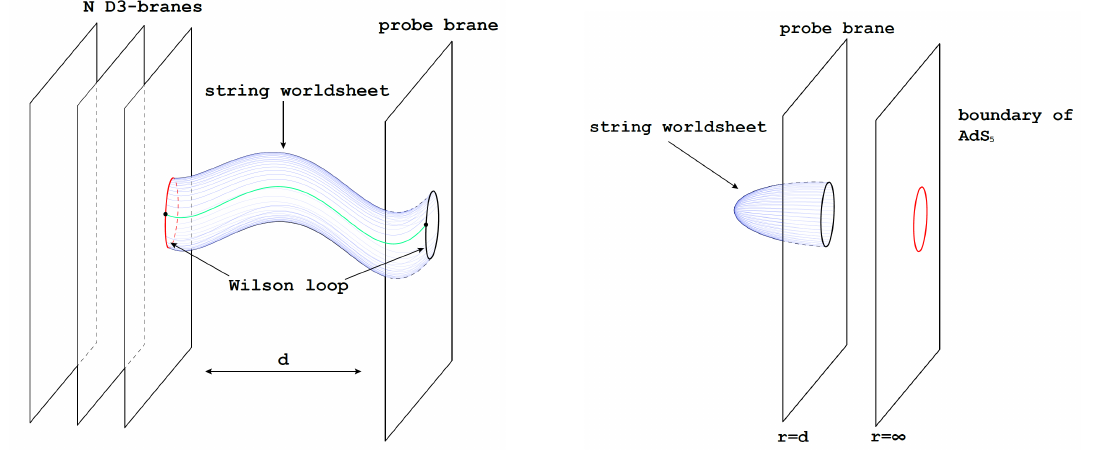
Figure 20 . Duality between Wilson loop and worldsheet in AdS/CFT. On the left figure, we showed the open string frame, where displacing a probe brane away from a stack of D branes leads to stretched worldsheets ending on Wilson loops. On the right we applied a geometric transition to obtain the closed string AdS × S 5 geometry where the worldsheet has only one boundary ending on the probe brane. This is a direct analogue of the duality between Wilson loops and worldsheets in topological string